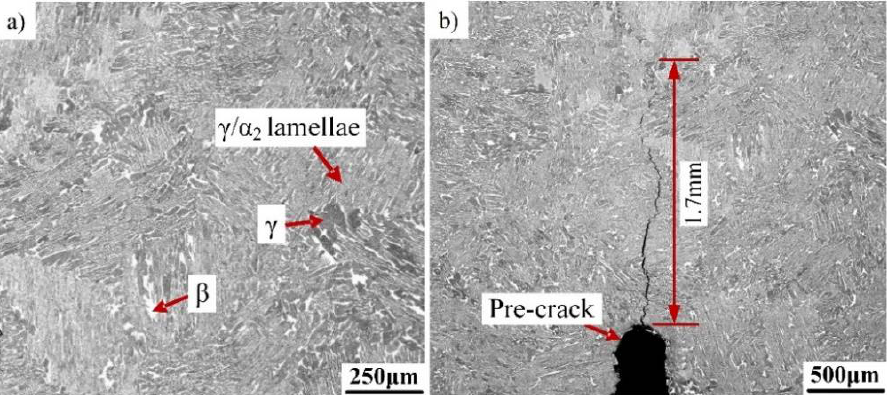
Figure 2. The microstructure ( a ) and the crack appearance ( b ) of the initial as-cast Ti-43Al-2Cr- 1.5Mn-0.1Y alloy. 0.1Y